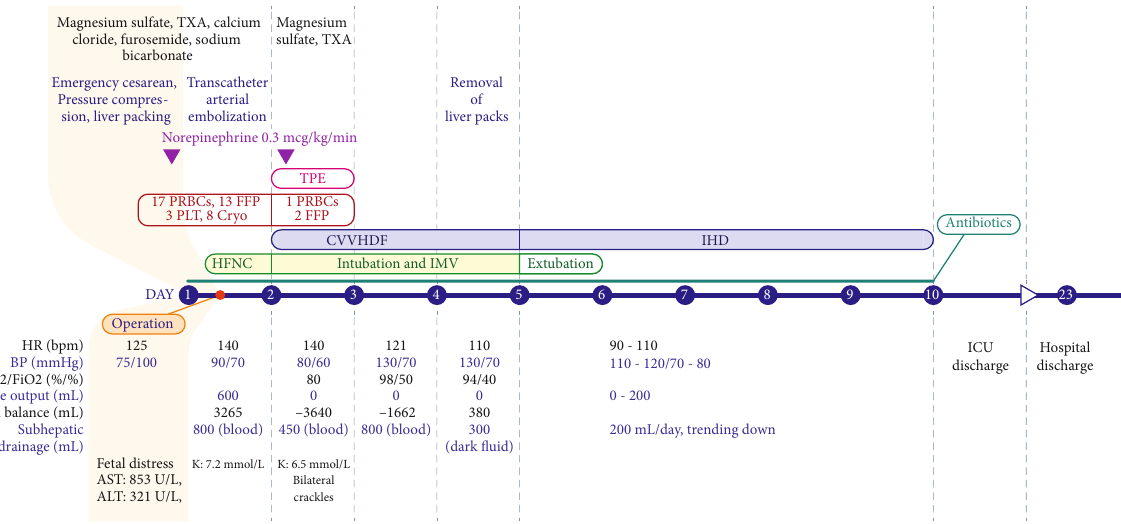
Figure 2: Progress of disease course. HR: heart rate; BP: blood pressure; SpO2: saturation of pulse oxygen; FiO2: fraction of inspired oxygen; PRBC: packed red blood cell; FFP: fresh frozen plasma; PLT: platelet; Cryo: cryoprecipitate; TPE: therapeutic plasma exchange; CVVHDF: continuous venovenous hemodia fi ltration; IHD: intermittent hemodialysis; HFNC: high- fl ow nasal cannula; IMV: invasive mechanical ventilation; ICU: intensive care unit; bpm: beats per